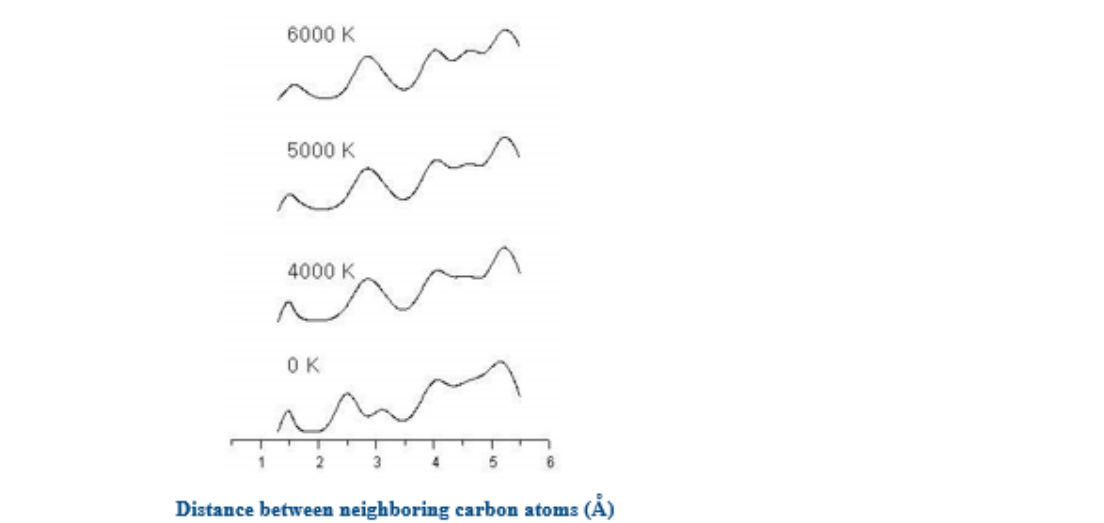
Figure 3. Radial distribution function of the distance (Å) between neighboring carbon atoms in the carbon nano-peapod structure at various temperatures.